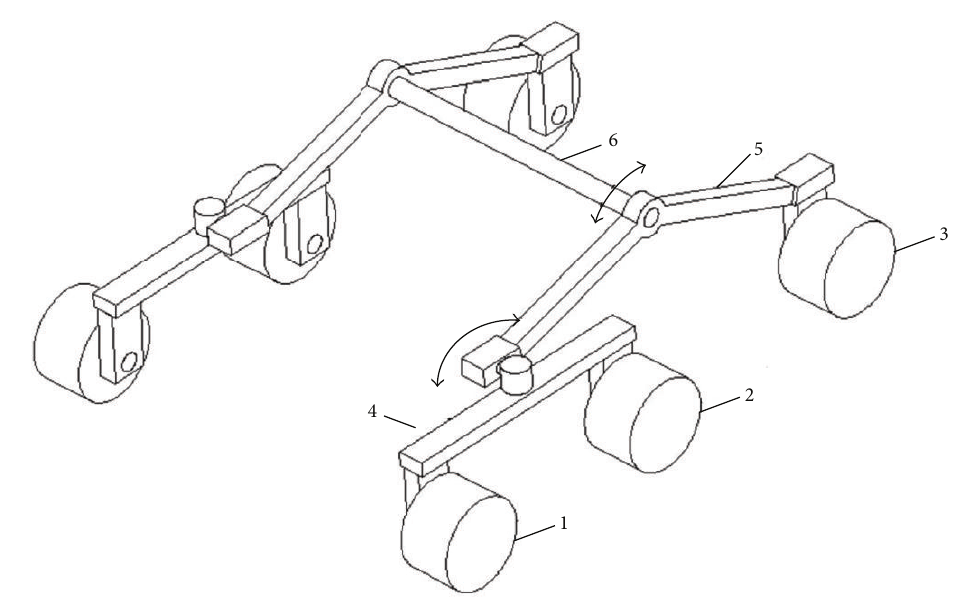
Figure 1: Rocker-bogie suspension system: 1, front wheel; 2, middle wheel; 3, rear wheel; 4, bogie; 5, rocker; 6, differential mechanism.